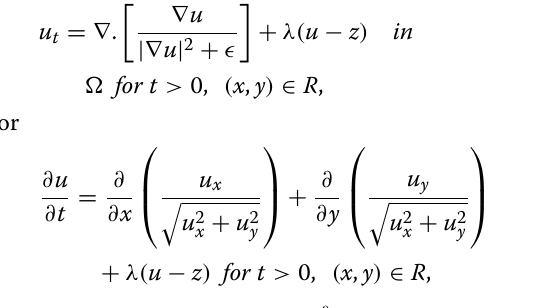
for the given u ( x , y , 0 ) , and also ROF model has the following disadvantages.